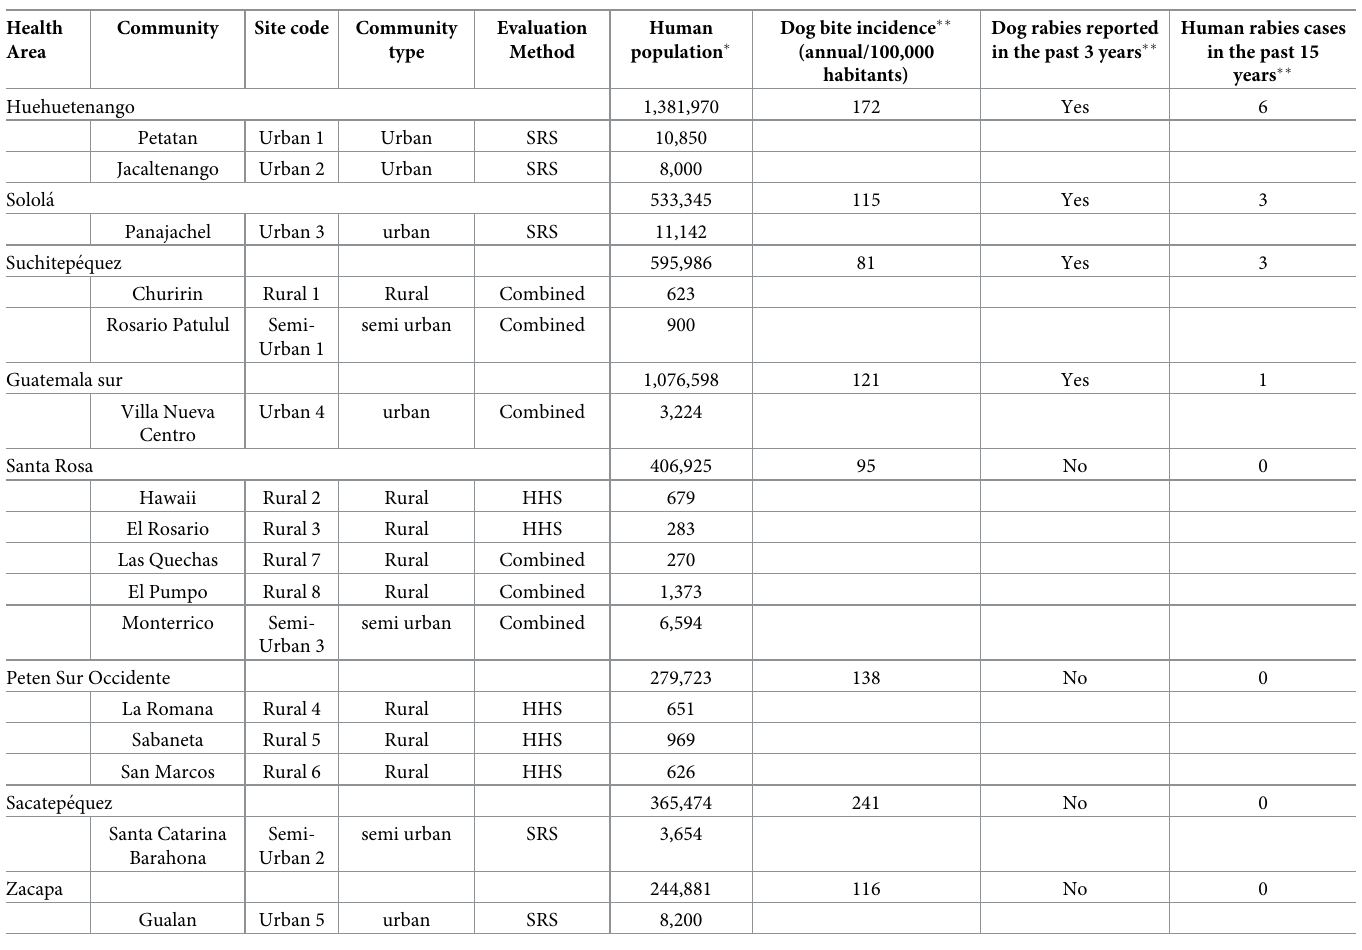
Table 1. Characteristics of the selected